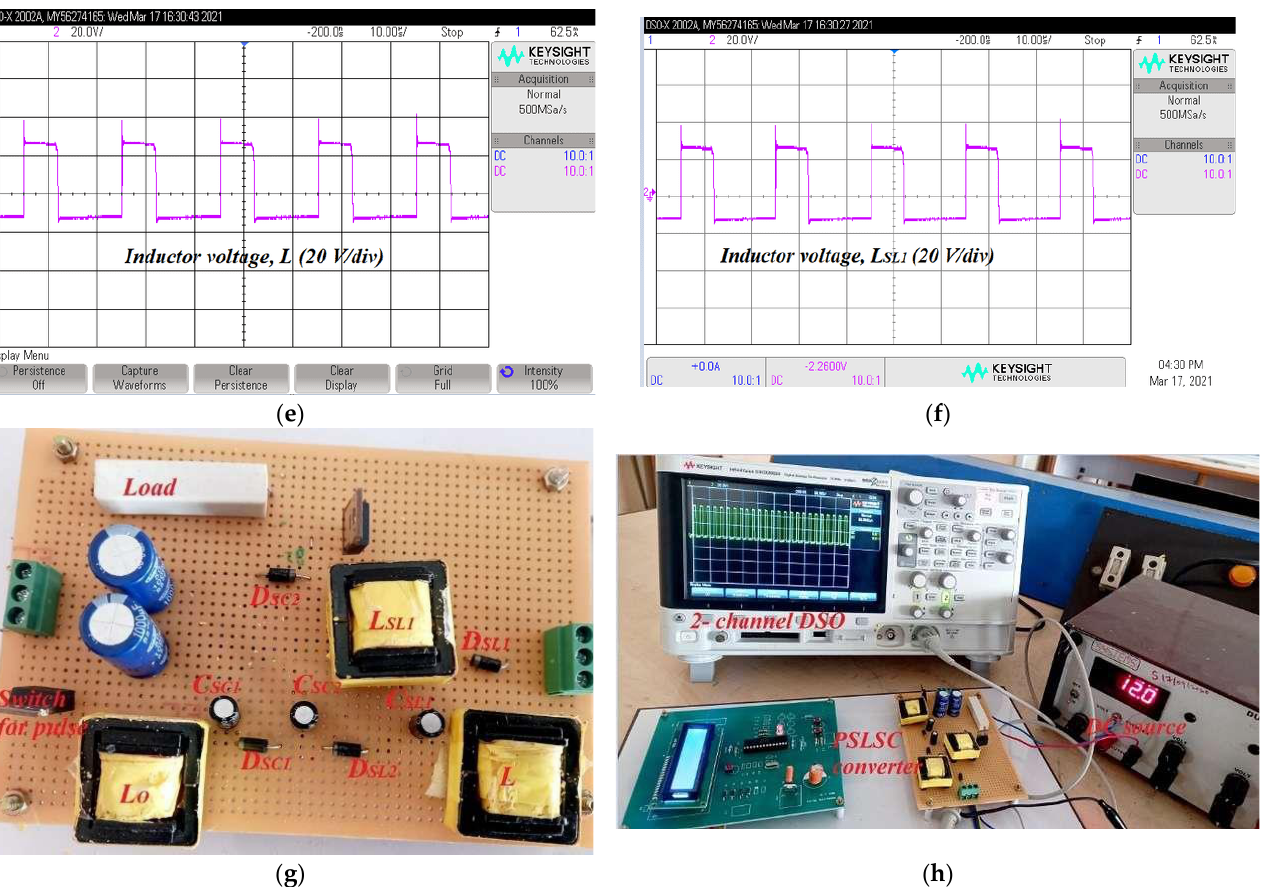
Figure 13. (a ) input voltage; ( b ) output voltage; ( c ) diode voltage; ( d ) switch voltage; ( e ) inductor L voltage; ( f ) inductor LSL1 voltage; ( g ) converter setup; ( h ) entire setup.